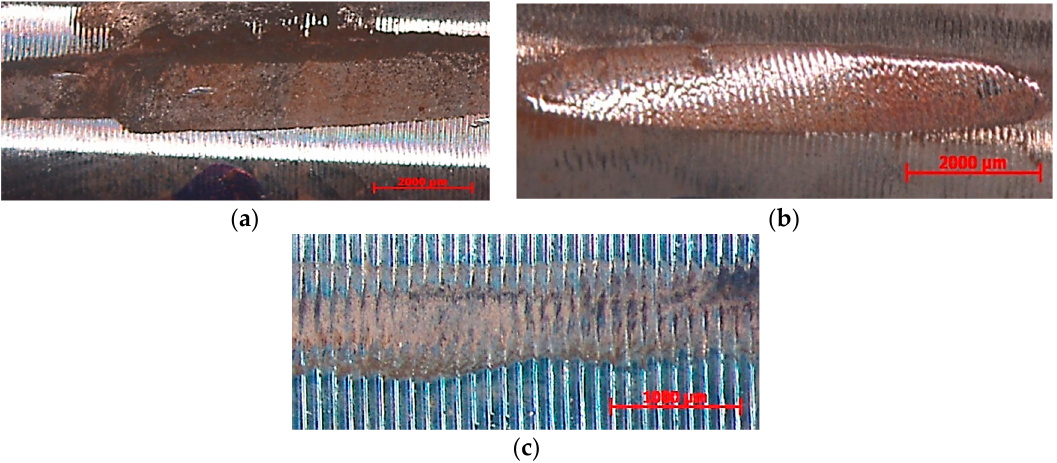
Figure 25. The example of wears of selected samples at tested configuration Cylinder/Cylinder. ( a ) Sample No. 10 without surface treatment (only heat-treated), 10× magnification; ( b ) sample No. 66 nitrided, 10× magnification; ( c ) sample No. 15 treated by electroless nickel plating, 10× magnification.